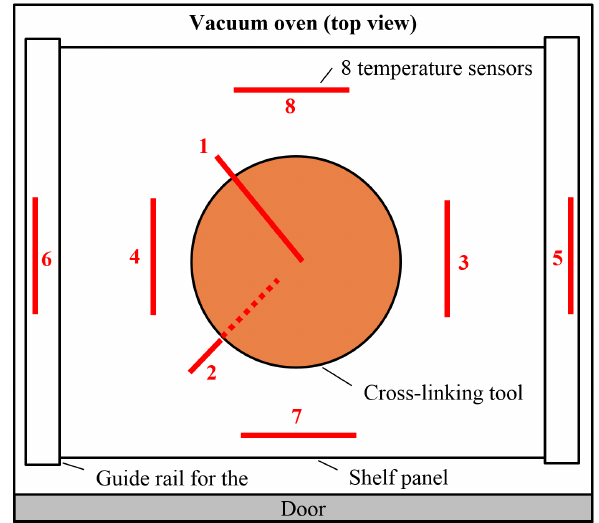
Figure 9. Sensor position in the cross-linking oven.